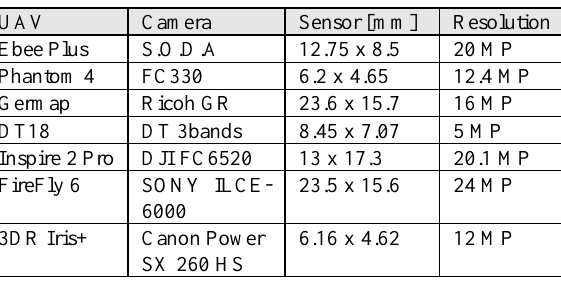
Table 1: UAV equipment and sensor specifications